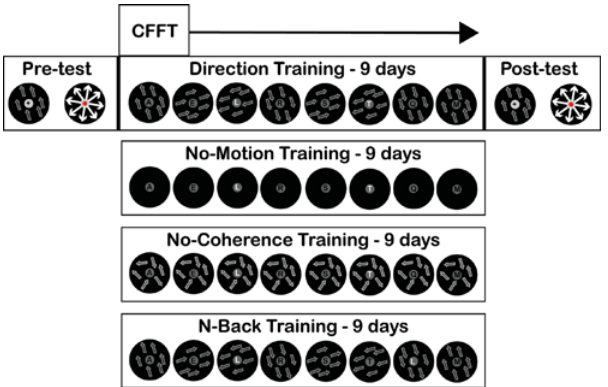
Figure 1. Experiment Design. For each group a direction discrimination test was performed before and after 9 days of training and CFFT was measured at the beginning of each training session. In Direction- Training, subjects reported two-targets (shown in white) at the end of the trial and a specific direction of motion was paired with task-targets. In No-Motion training, task was the same, but no dots were displayed. In No-Coherence training, task was the same but dots all moved randomly. In N-Back training, task was to report if a letter was repeated twice in a trial (in this case the L; shown in white for graphic purposes), there was no relationship between task-targets and motion